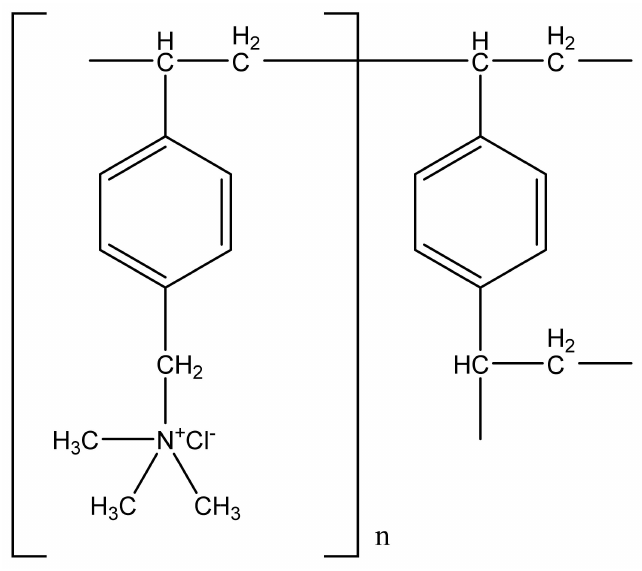
Scheme 2. Chemical structure of anion exchanger